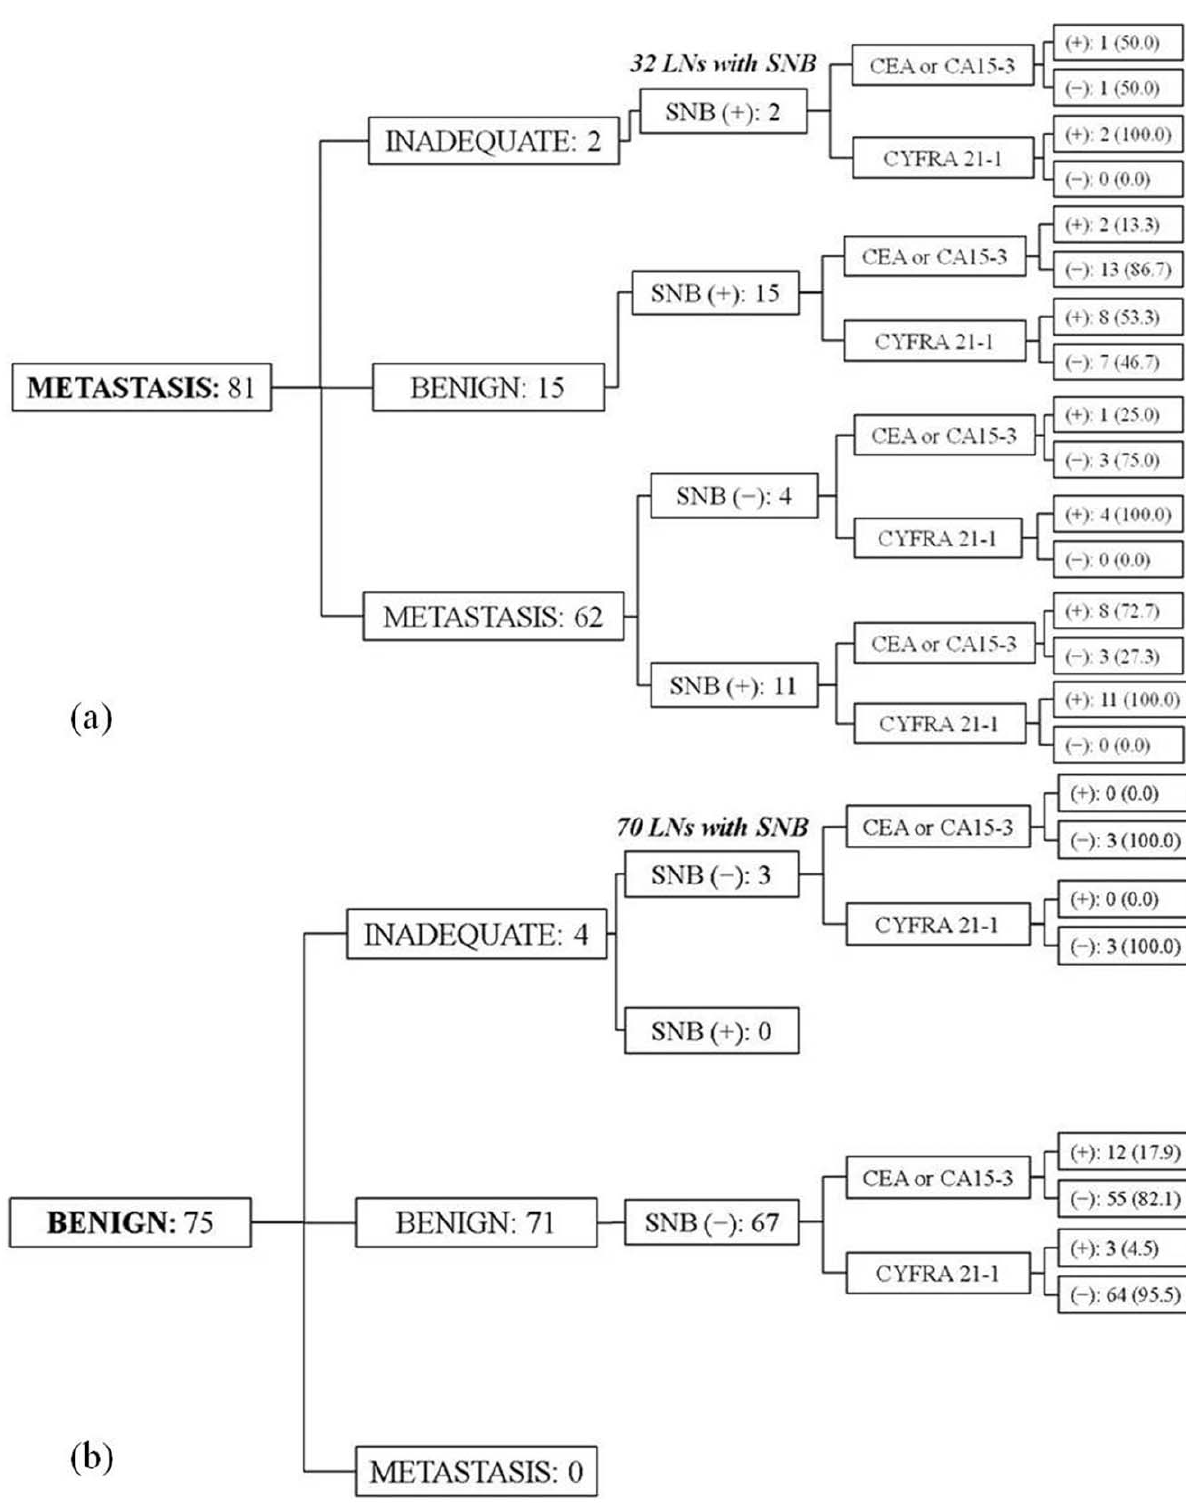
Figure 2. Diagram of US-FNAB, SNB and tumor markers in proven metastatic (a) and benign (b) lymph nodes. doi:10.1371/journal.pone.0057248.g002 SNB. Eight (53.3%) of the 15 LNs showing benign cytology had CYFRA 21-1 concentrations categorized as positive, while only 2 (13.3%) and 3 (20.0%) LNs were categorized as positive when